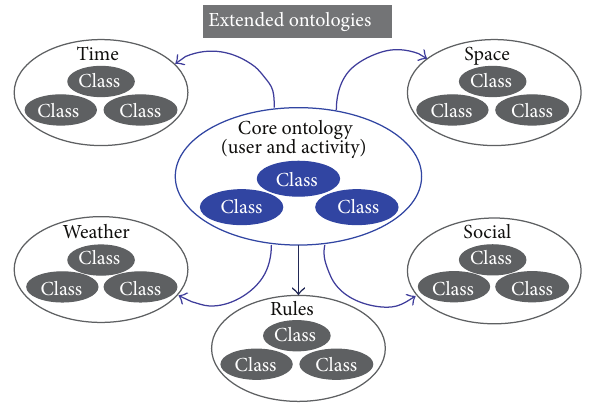
Figure 1: Conceptual profile of the factors influencing physical activity assessment and